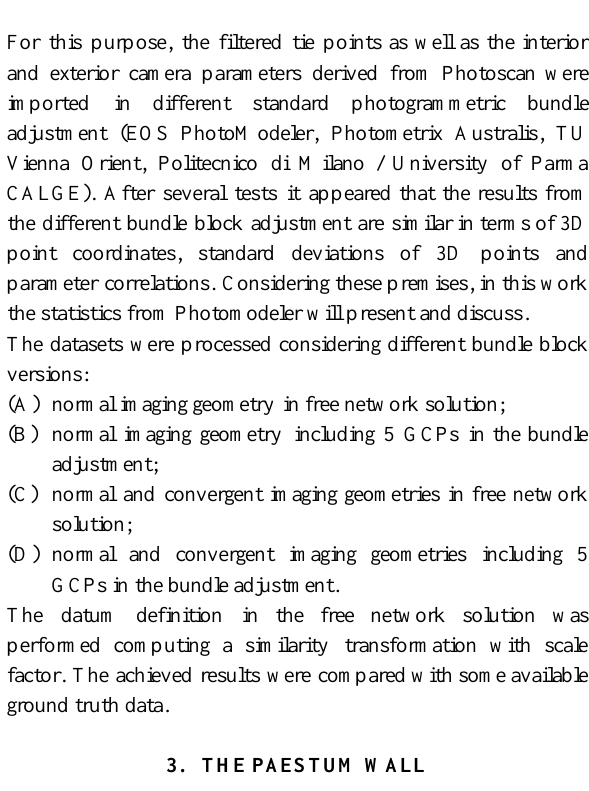
Figure 2: The Ventimiglia network (a) with normal / vertical (green) and convergent / oblique (red) images. Orthophoto of the theatre (b) with the GCPs (red points) and CPs (blue points) distribution (b).